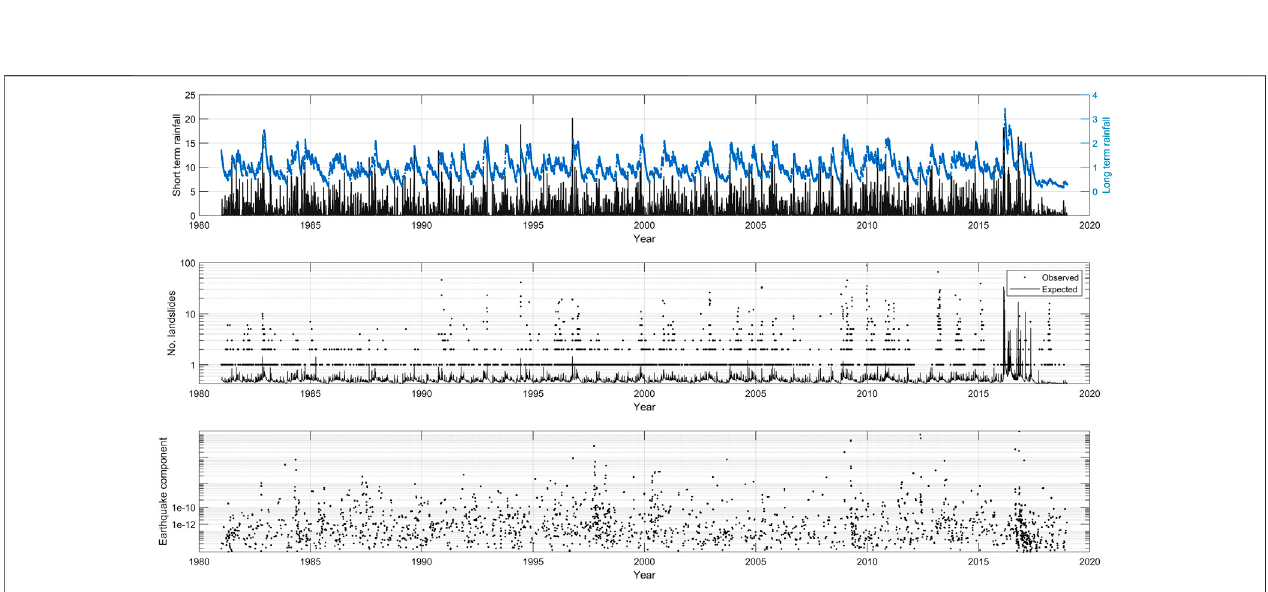
FIGURE 9 | Estimated location susceptibilities for Model 2B (left) and 2D (right) .